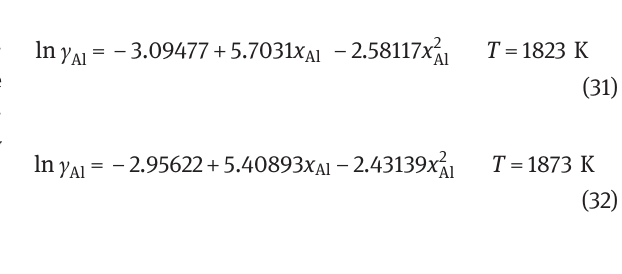
Figure 8: Comparison of reported results of activity a R,Al of Al by various researchers with obtained ones by developed AMCT – N i model for three categories of Fe – Al binary melts (a, b, c) with different ranges of mole fraction x Al of Al at various temperatures greater than 1373 K (1100°C),